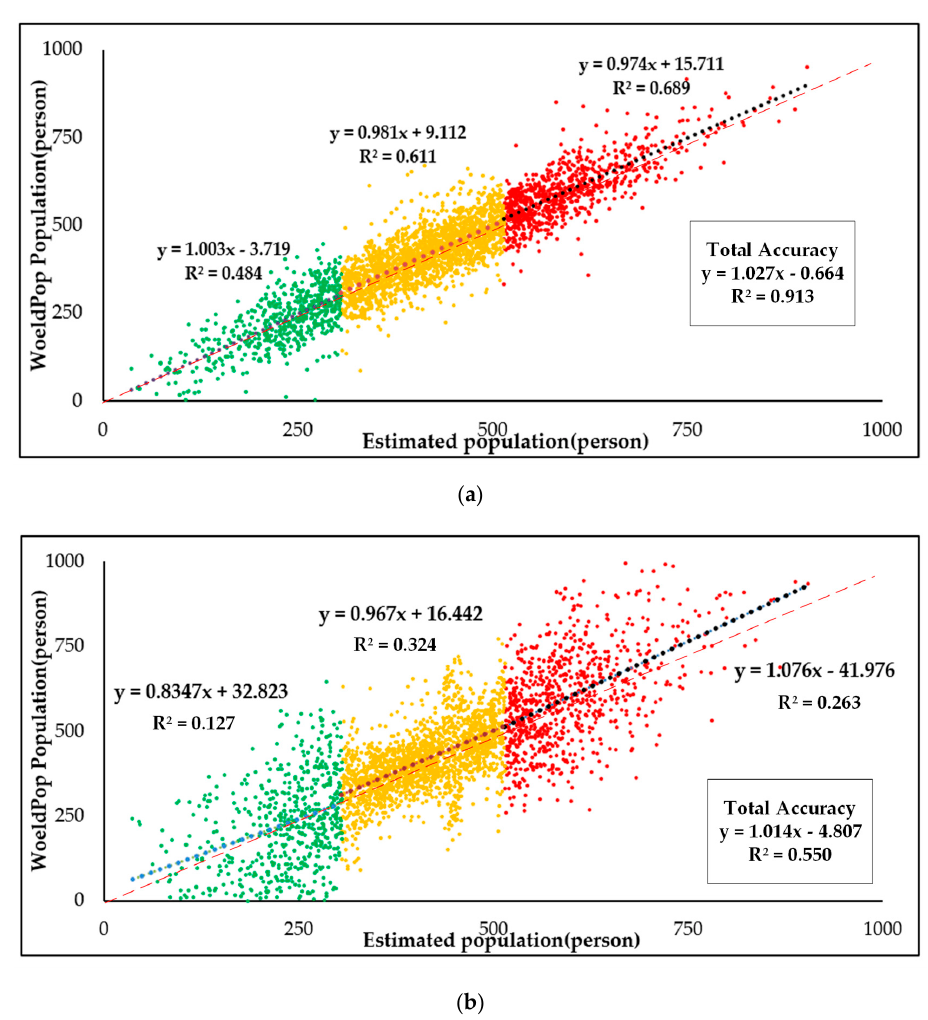
Figure 9. Correlation between the WordPop and population mapping results with ( a ) and without ( b ) considering the check-in points.